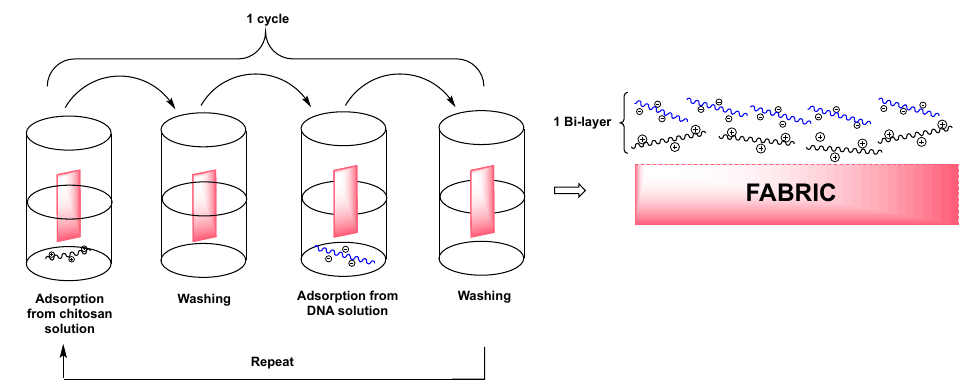
Figure 30. Scheme of the chitosan-DNA LbL assembly.